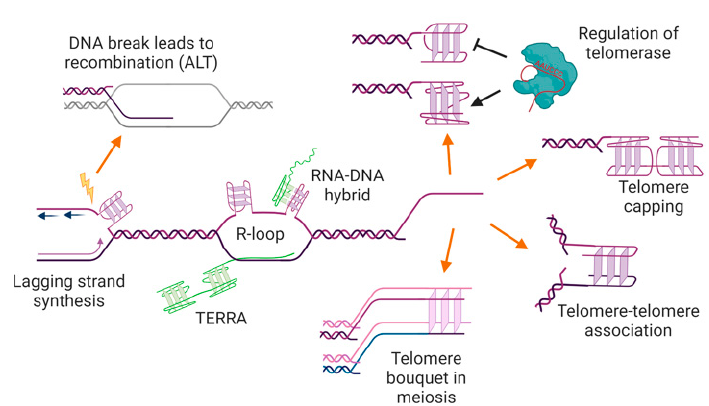
Figure 4. Potential locations, functions, and consequences of G-quadruplexes at telomeres. G-quadruplexes may form in the single-stranded telomere overhang, where they may positively or negatively regulate telomerase and/or have a capping function, preventing access to the DNA repair machinery. G-quadruplexes at overhangs may also mediate interactions between two telomeres (e.g., during sister chromatid cohesion, or in the macronucleus of ciliated protozoa), or be involved in telomere clustering in meiosis. G-quadruplexes could also form in the double-stranded region of the telomere during DNA replication or transcription, where they may trigger genome instability and/or recombination-mediated telomere maintenance. The RNA transcribed from telomeres, TERRA, can also form into G-quadruplexes, either unimolecular or as an RNA-DNA hybrid. See text for details and references. Figure created with BioRender.com.